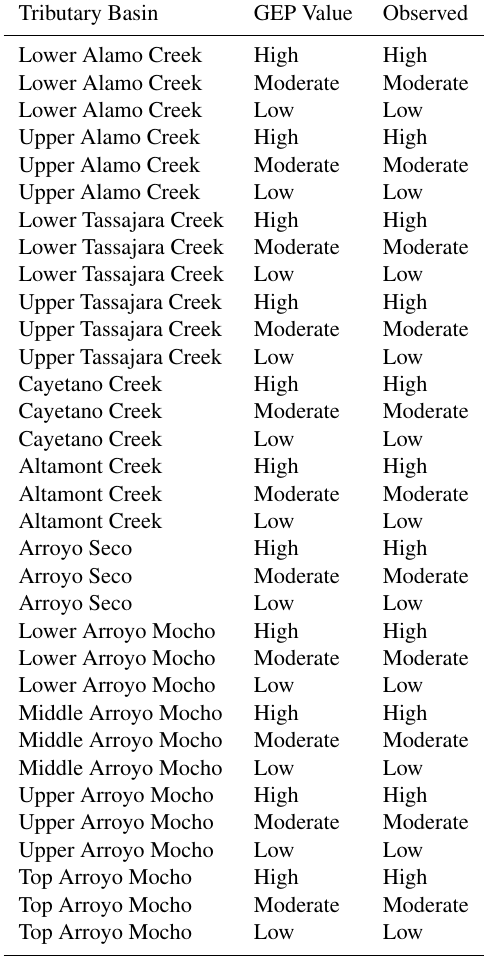
Table 1. Summary of agreement between erosion (GEP) predic- tions and erosion observed on air photos and in the